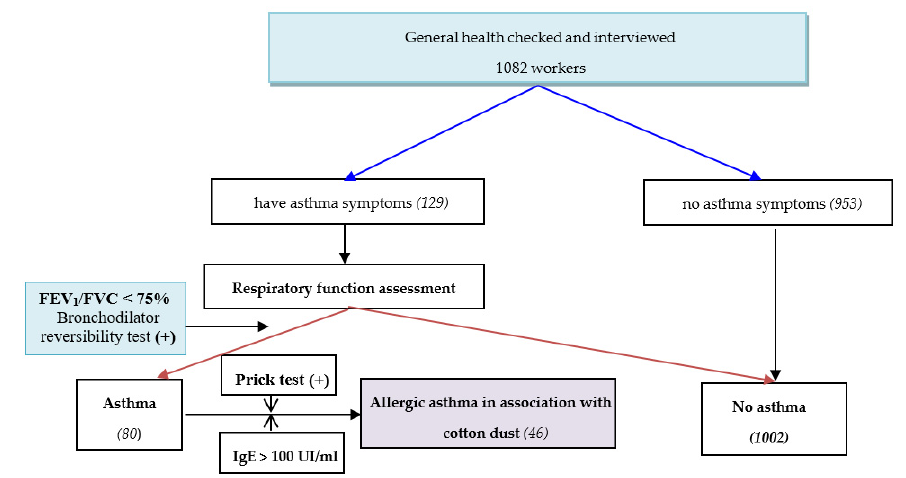
Figure 1. The study processes. (+):